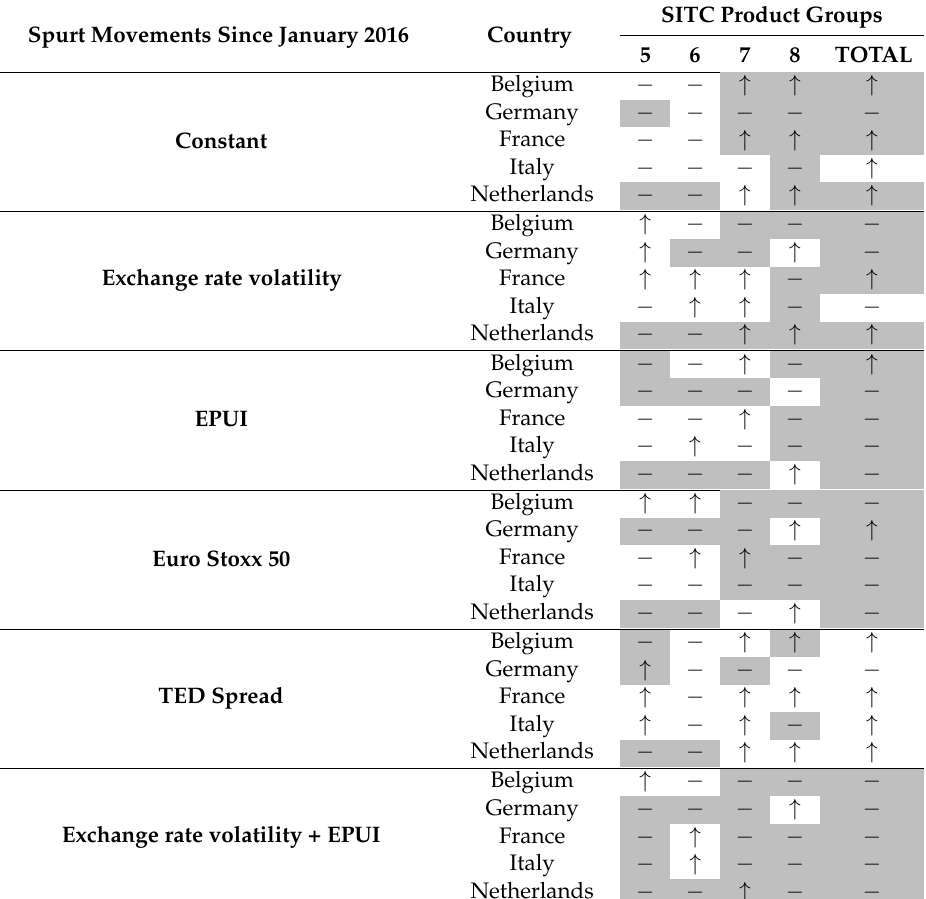
Table 2. Spurt movements between January and April